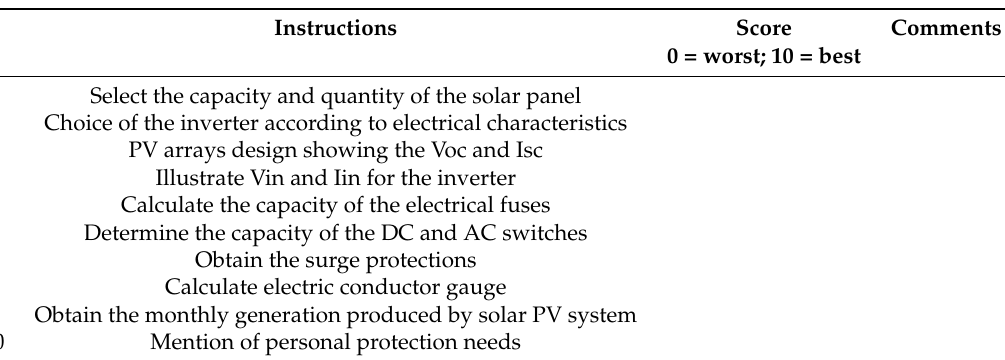
Figure 8. The experimental teaching process. Table 2. Evaluation